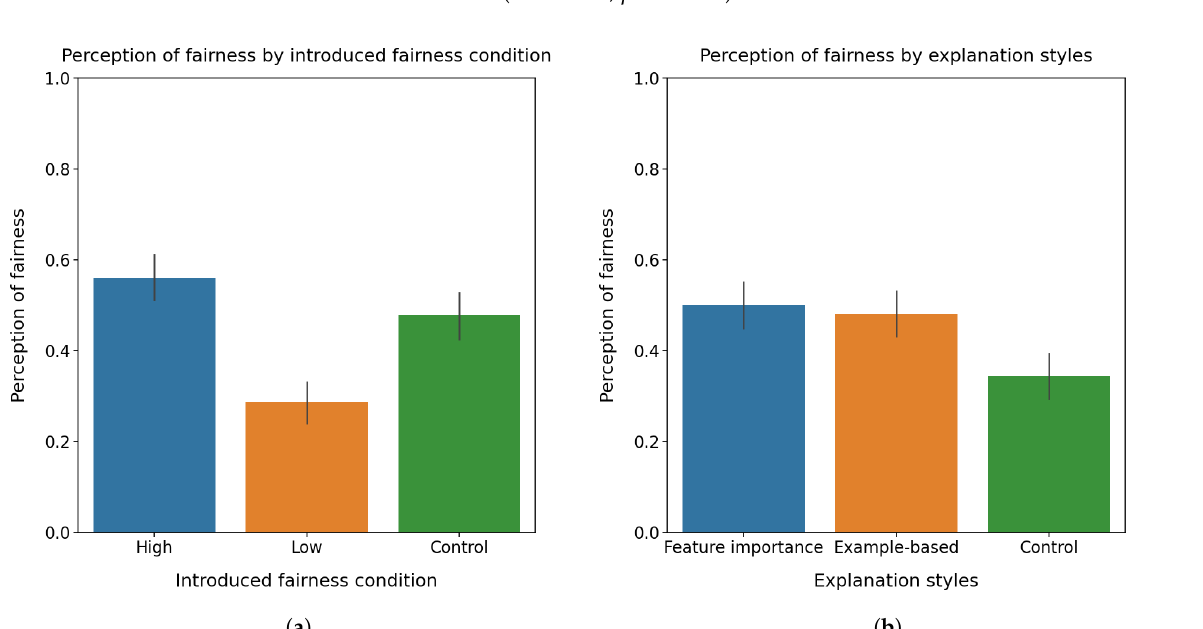
Figure 6. Perception of fairness. ( a ) perception of fairness under different introduced fairness conditions; ( b ) perception of fairness under different explanation